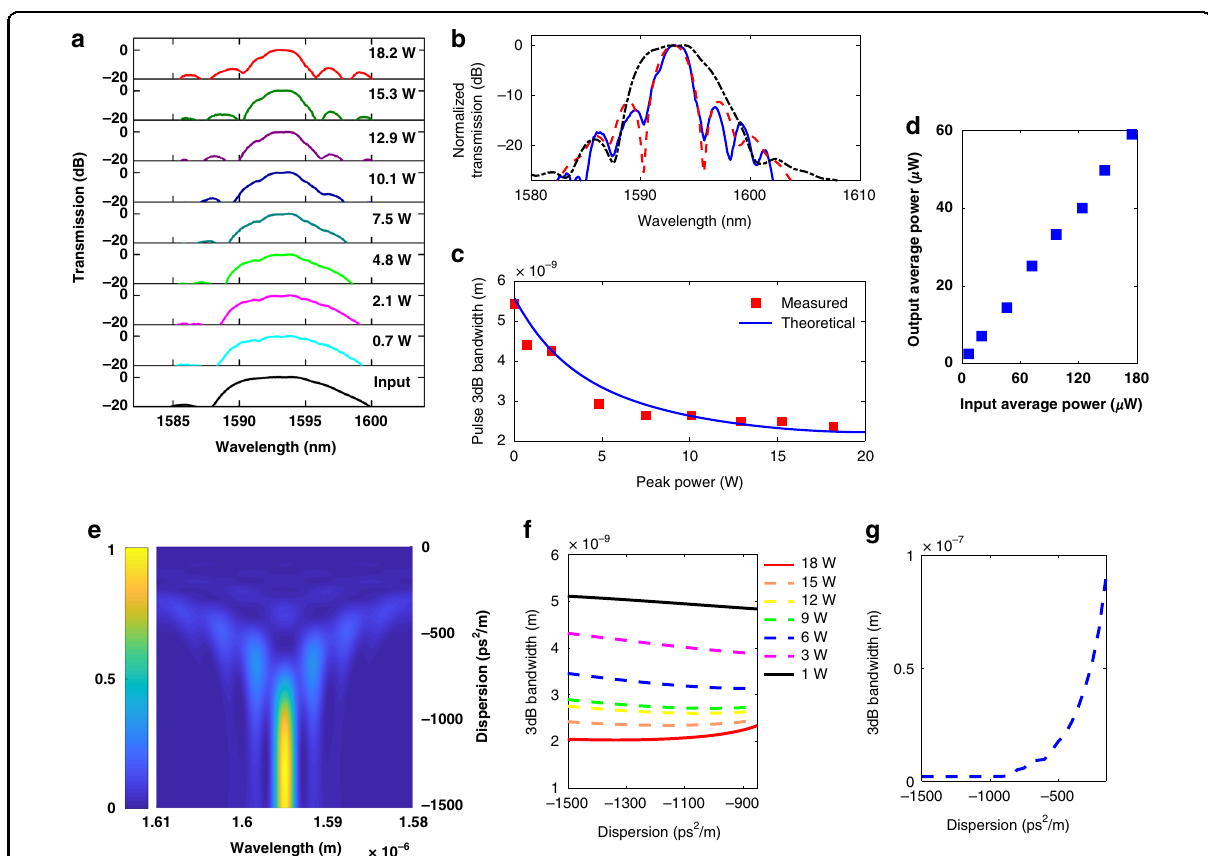
Fig. 5 Experimental demonstration of spectral compression using Device 2 ( β 2(grating) = − 890 ps 2 m − 1 ). a The measured output spectrum of the USRN compressor system when used as a spectral compressor as input peak power is increased. b The measured pulse spectrum for the source (black) and at the spectral compressor output when P peak(in) = 18.2 W (blue) (pulse energy = 8.7 pJ). 2.3× spectral compression is achieved. The theoretical output pulse spectrum for P peak(in) = 18.2 W is shown as the red dashed line. c The measured (red squares) and theoretical (blue line) 3 dB bandwidth (from Fig. 3c) of the output pulse as a function of input peak power. d Experimentally measured output average power vs. input average power. e Calculated output of the spectral compressor for a 480 fs input pulse with P peak(in) = 18.2 W as a function of the grating dispersion. f Calculated 3 dB bandwidth of a spectrally compressed 480 fs input pulse as a function of dispersion magnitude in the dispersive stage, for different values of P peak(in) . g Calculated output 3 dB bandwidth for 480 fs input pulses as a function of dispersion magnitude in the dispersive stage, for P peak(in) = 18.2